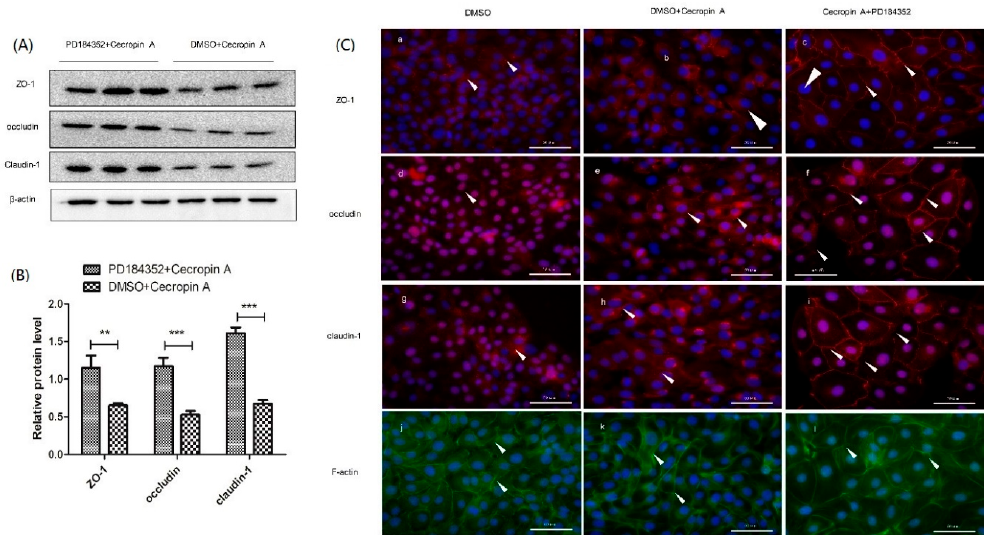
Figure 6. The inhibitory effects of MEK/ERK on TJ protein expression, membrane distribution and F-actin polymerization. Western blotting analysis of ZO-1, occludin and claudin-1 expression (( A , B ), n = 3); cell immunofluorescence ((C), n = 3, 400×) showed the membrane distribution ( a – i ) and F-actin polymerization ( j – l ). The results were confirmed by three independent experiments per treatment. Representative results of the three independent experiments are shown. Data (mean ± SEM) were analyzed with the Student’s t -test. Cell nuclei were stained by DAPI and are shown in blue. Claudin- 1, ZO-1 and occludin are shown in red and pointed out by white arrow heads. F-actin is shown in green. Scale bar is 50 μ m. ** p < 0.01, *** p < 0.001.